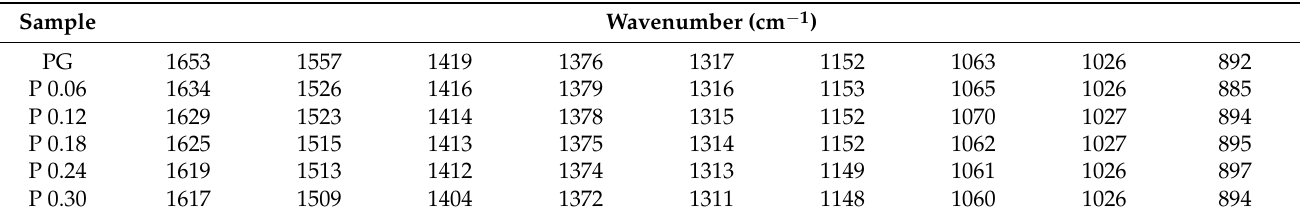
Table 3. The peaks of the characteristic FTIR bands from the fingerprint region of PG and the samples with different gold concentrations.